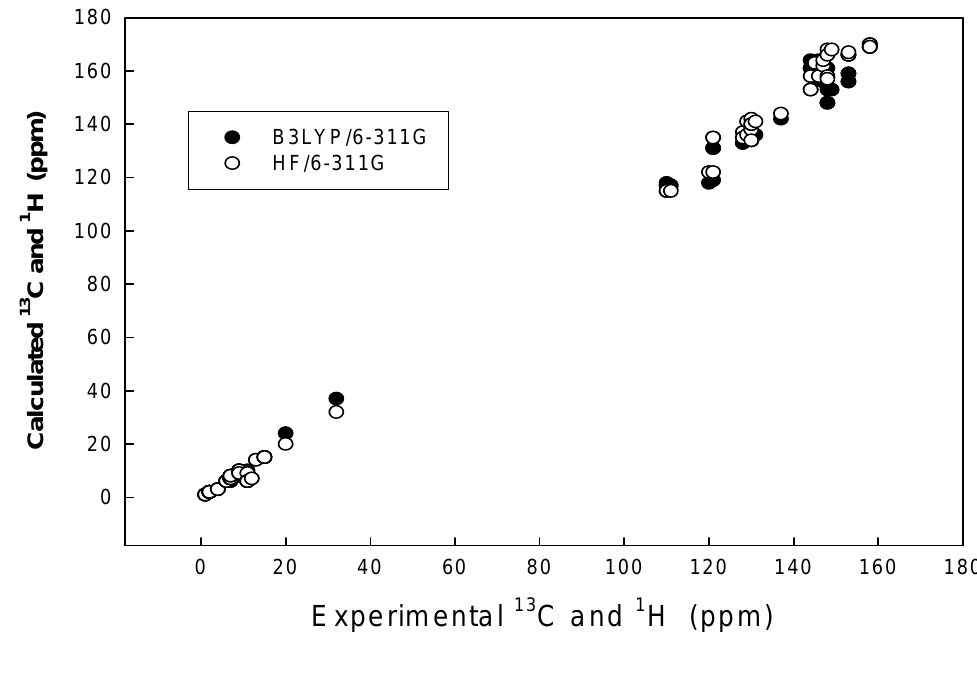
Experimental 13 C and 1 H